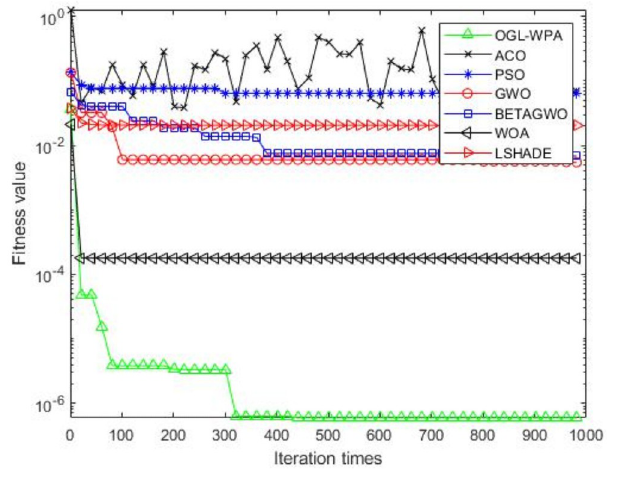
Fig 10. F9 iteration curve.